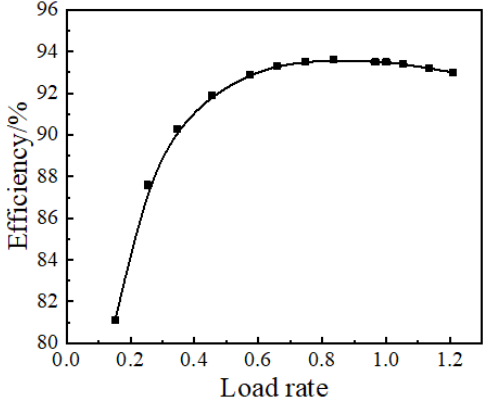
Figure 28. The power factor curve ( U = 174.3 V).